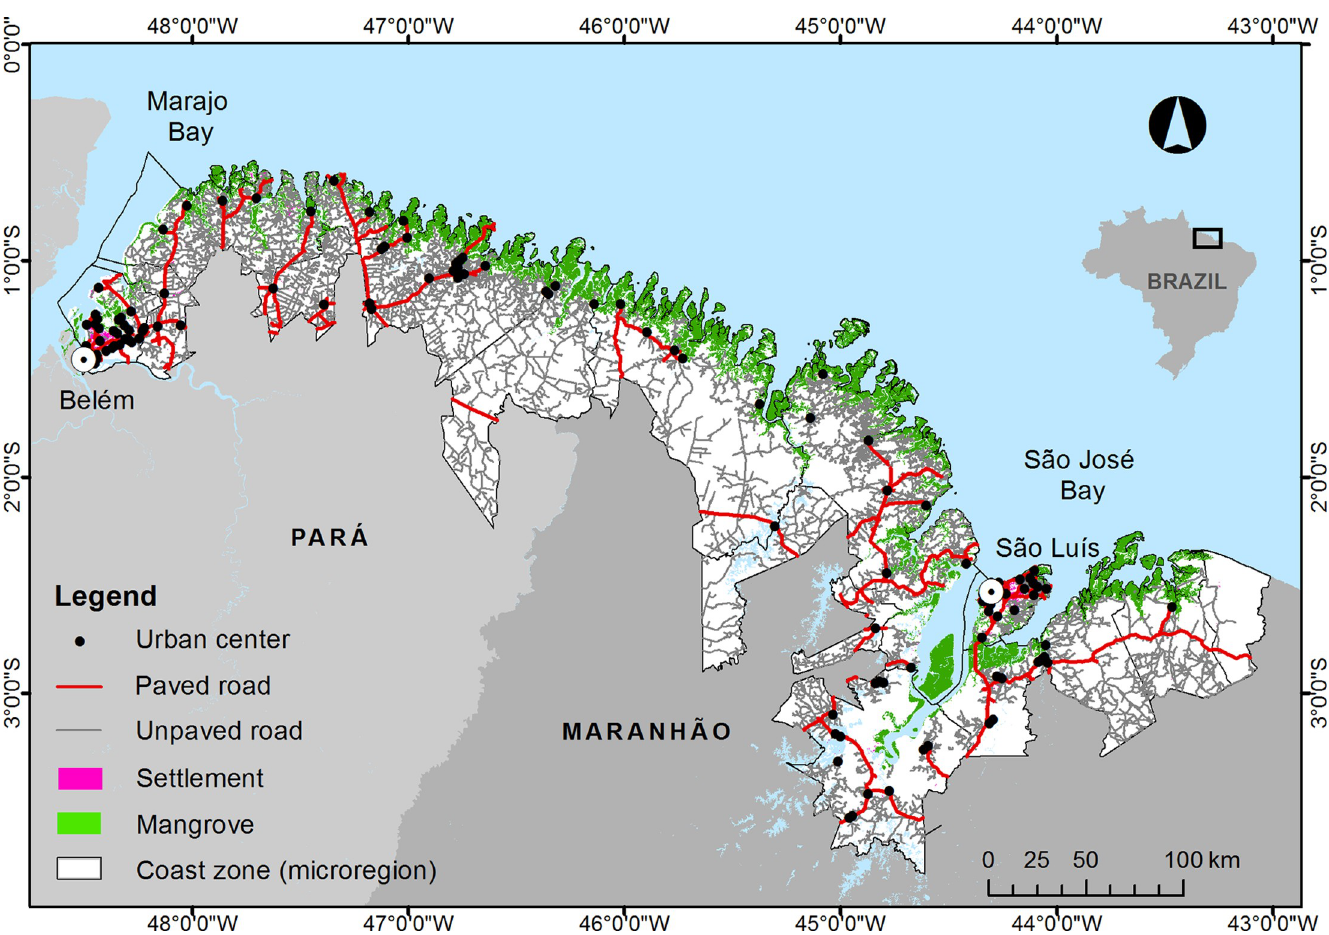
Fig 5. Spatial distribution of the principal anthropogenic drivers (urban centers, paved and unpaved roads, and settlements) associated with mangrove land use on the Brazilian Amazon coast.